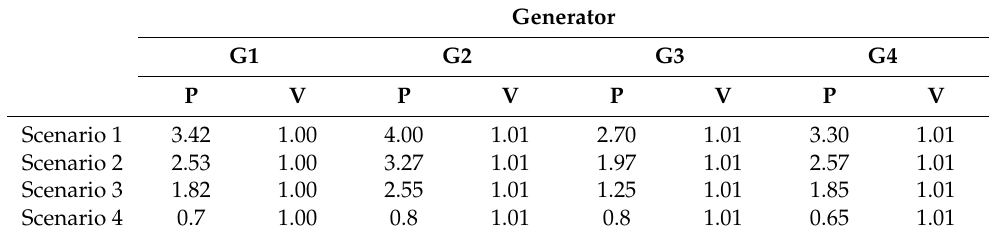
Table 2. Operating conditions of the synchronous